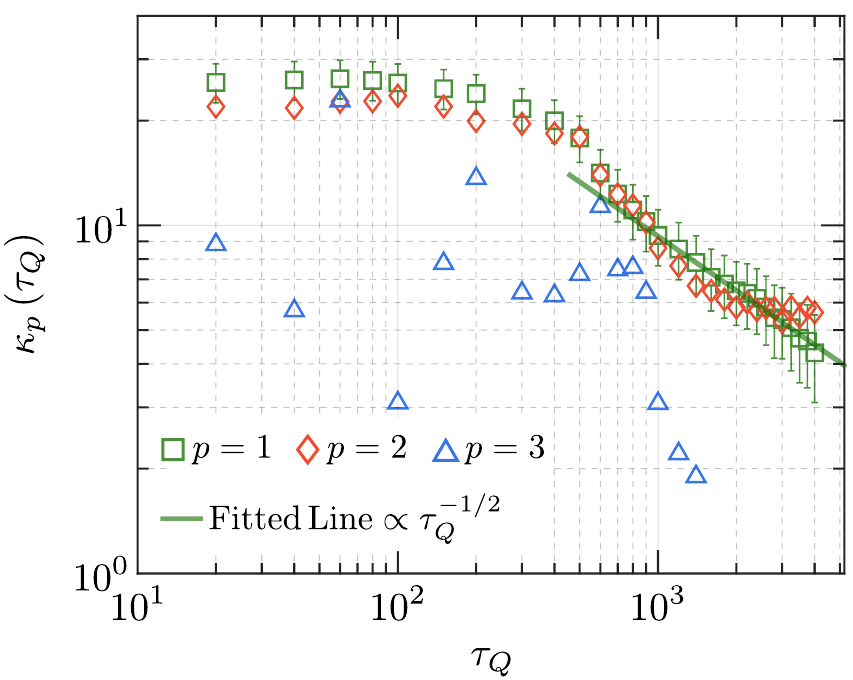
Figure 3 . Universal scaling of low-order cumulants of the vortex number distribution. The solid line is the fitting of the κ 1 , with power κ 1 ∼ τ − 1 / 2 . The error bars stand for standard deviations. Within Q error bars, the variance of the vortex number quantified by the second cumulant exhibits the same power-law scaling and its magnitude is consistent with that of the mean vortex number, indicating Poissonian statistics. Finite sampling statistics generally prevents establishing the universal scaling of high-order